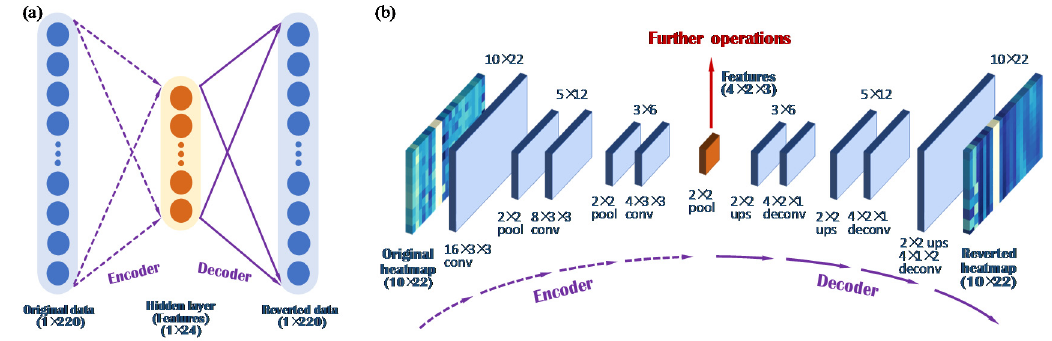
Figure 1. Graphical structures of the ( a ) fully connected autoencoder (FCAE), ( b ) deep convolutional autoencoder (DCAE).